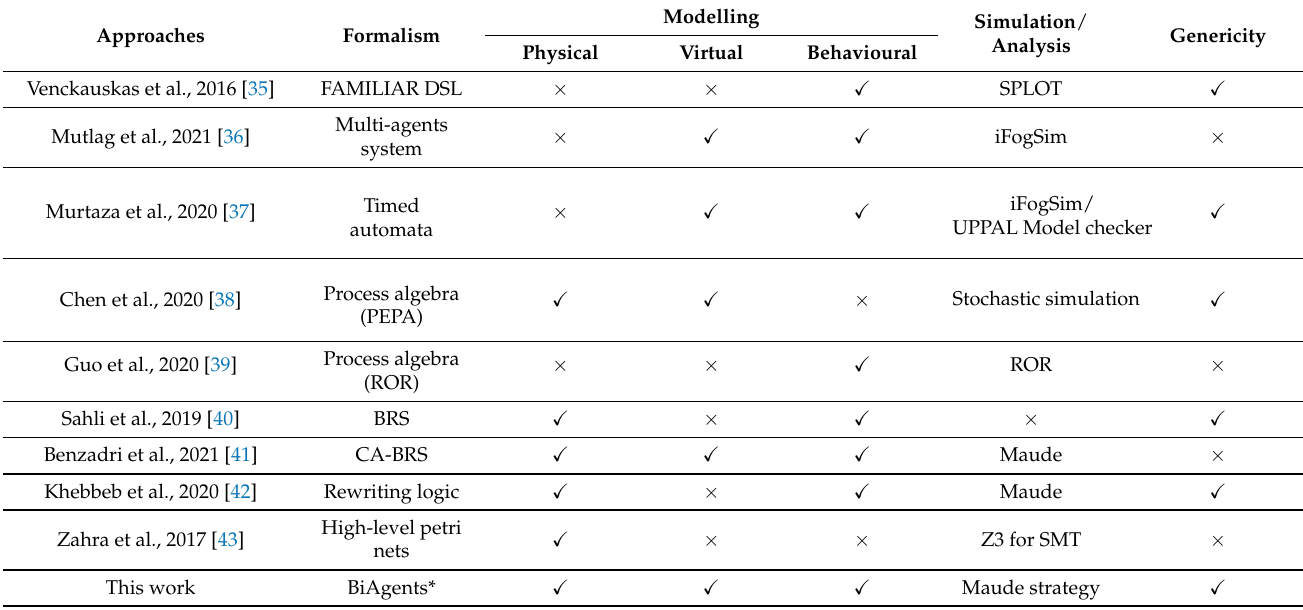
Table 11. Fog systems formal modelling